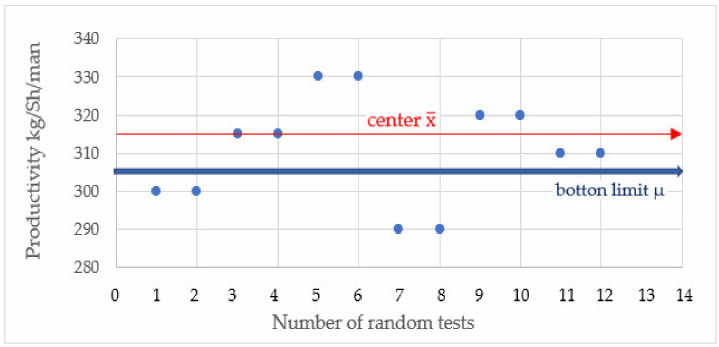
Figure 5. Graphic illustration of iron work performances, including the mean